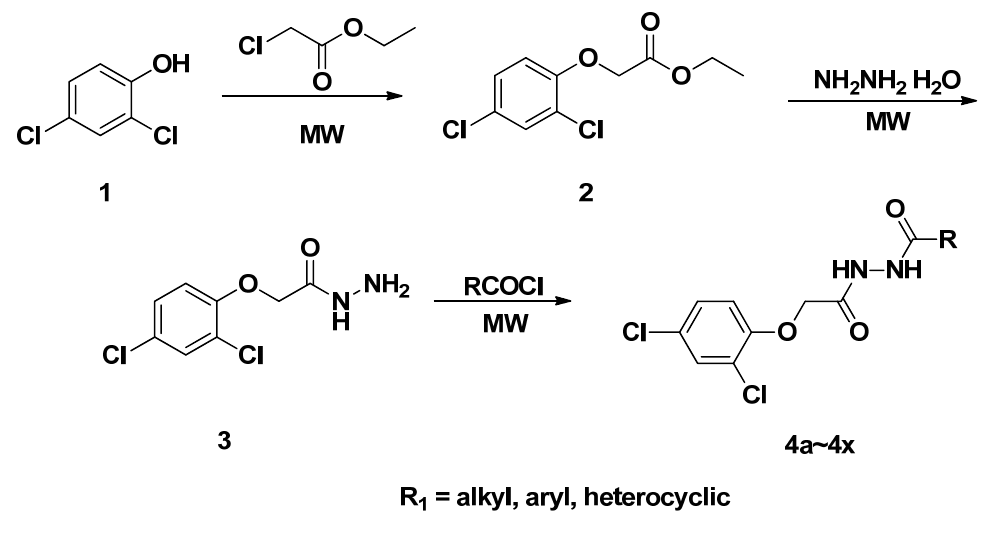
1 shows that compound 4b exhibited excellent antifungal activity against Sphaerotheca fuligenea and so the half maximal effective concentration (EC The EC results showed that compound 4b had weaker activity against Sphaerotheca fuligenea than 50 that of control